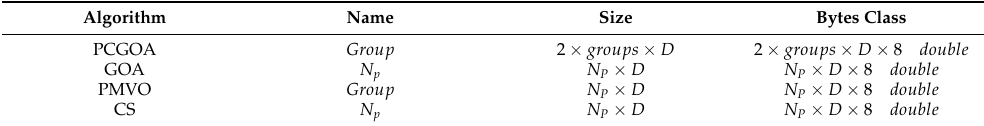
Table 3. Computer storage of populations at each